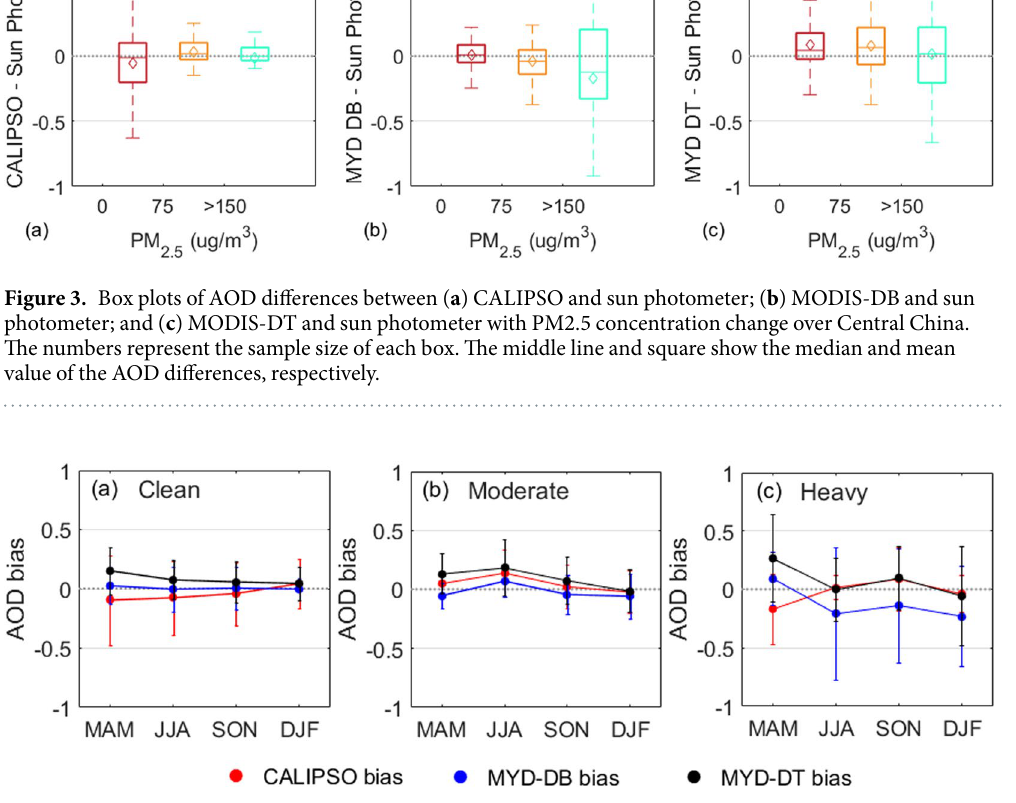
Figure 4. The seasonal deviation of AOD products under the different air quality conditions ( a ) The clean air quality (PM2.5 < 75 µ g m–3); ( b ) the moderate air pollution (75 < PM2.5 < 150 µ g m–3); and ( c ) the heavy air pollution (PM2.5 > 150.0 µ g m–3). The red, blue, and black lines show the CALIPSO bias, MYD_DB bias, and MYD_DT bias,